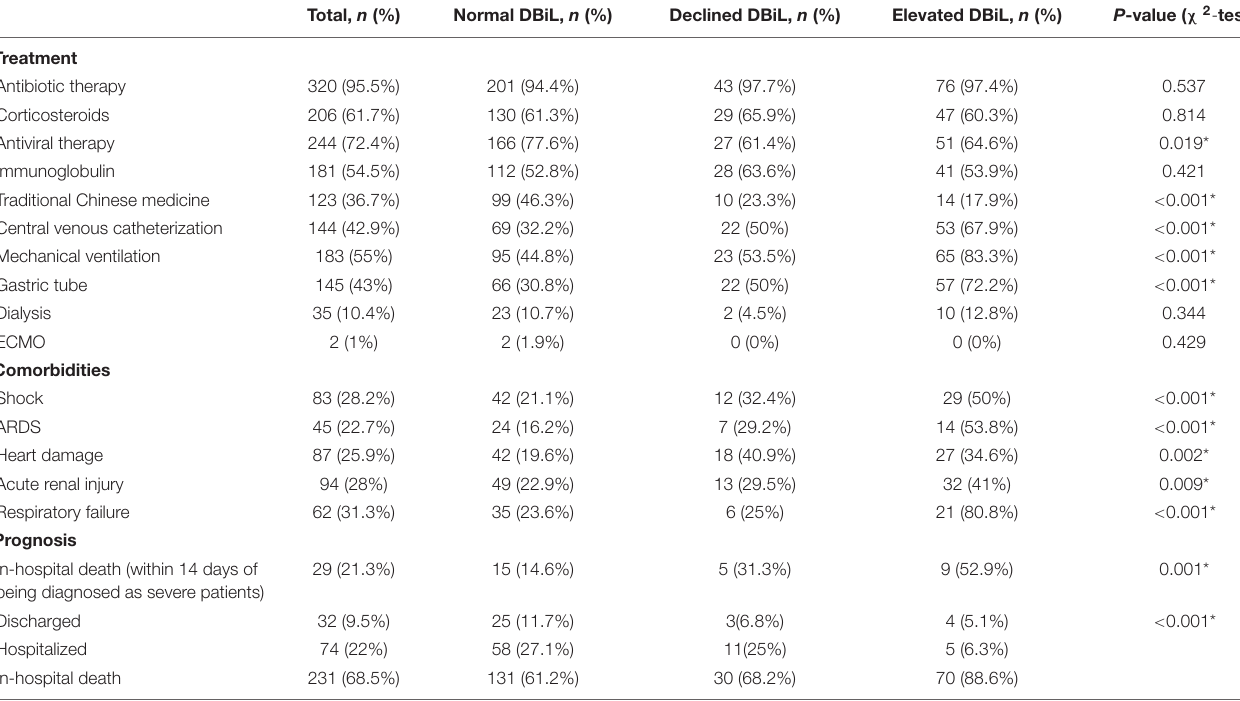
TABLE 3 | Treatment, comorbidities and prognosis of 337 COVID-19 severe/critically ill patients. Total, n (%) Normal DBiL, n (%) Declined DBiL, n (%) Elevated DBiL, n (%) P -value ( χ 2 - test)